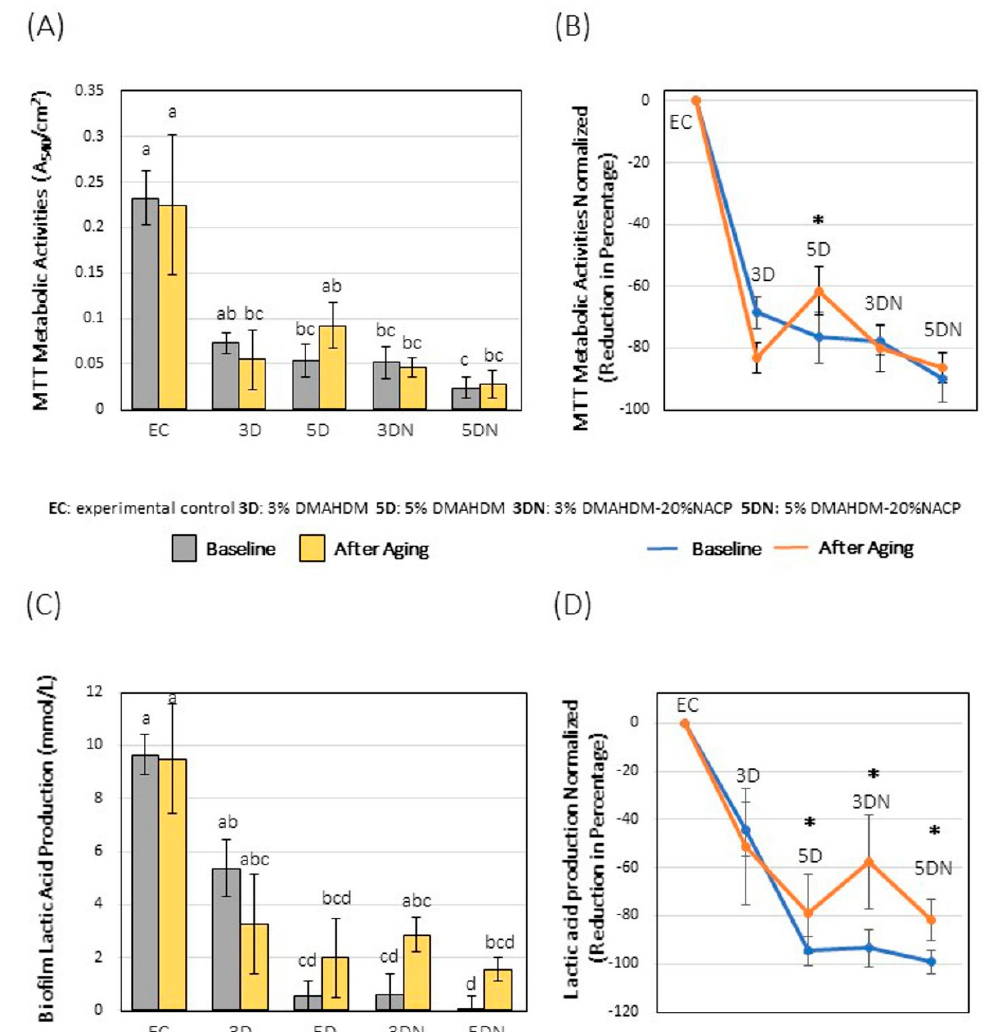
Figure 4. ( A ) The metabolic activities and ( C ) lactic acid production of the biofilms grown over the baseline and aged samples (mean ± SD; n = 9). Different letters indicate significant differences between groups ( p < 0.05). The normalized data of the ( B ) metabolic activities and ( D ) lactic acid reduction in percentage. * Asterisks indicate significant differences compared to baseline values before aging. (EC = experimental control; 3D = 3% DMAHDM; 5D = 5% DMAHDM; 3DN = 3% DMAHDM-20% NACP; 5DN = 5% DMAHDM-20% NACP).